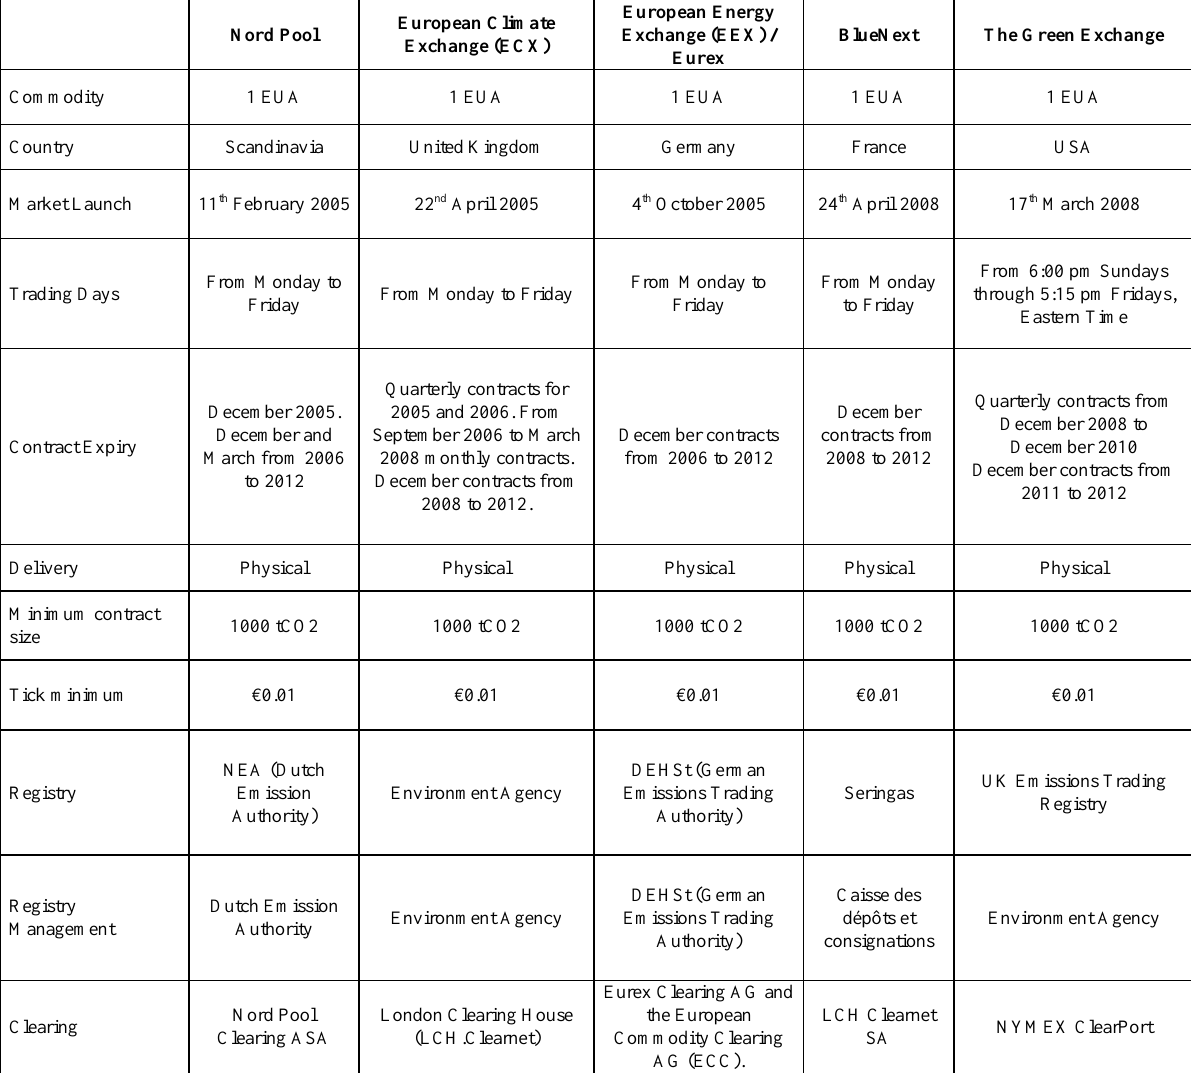
Table 4. Futures Trading Rules Details in Organized